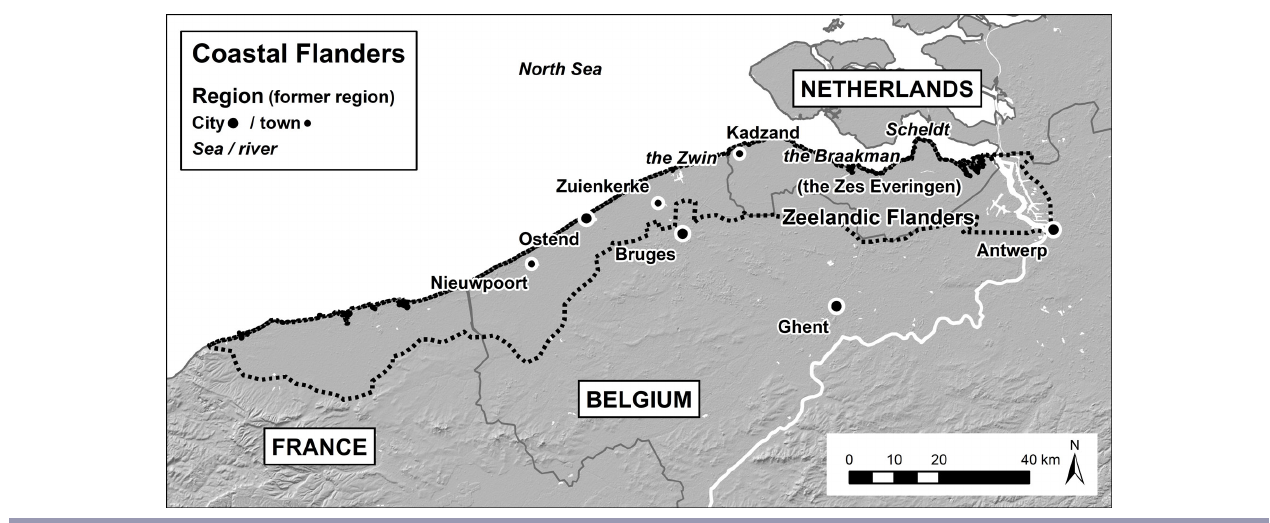
Fig. 2 . Map of coastal Flanders, indicating the localities mentioned in the text. Iason Jongepier, GIStorical Antwerp (UAntwerpen/Hercules